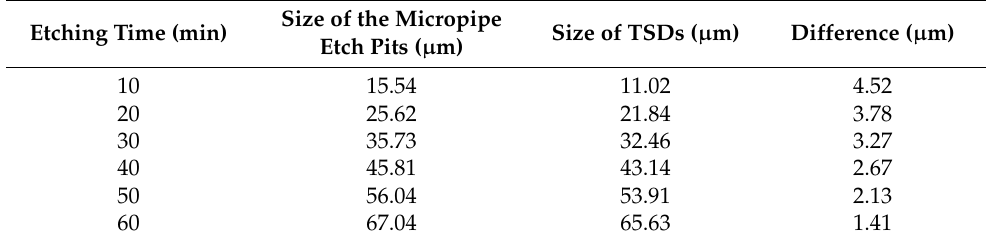
Table 1. The size difference between 4H-SiC micropipe etch pits and TSDs with etching time.